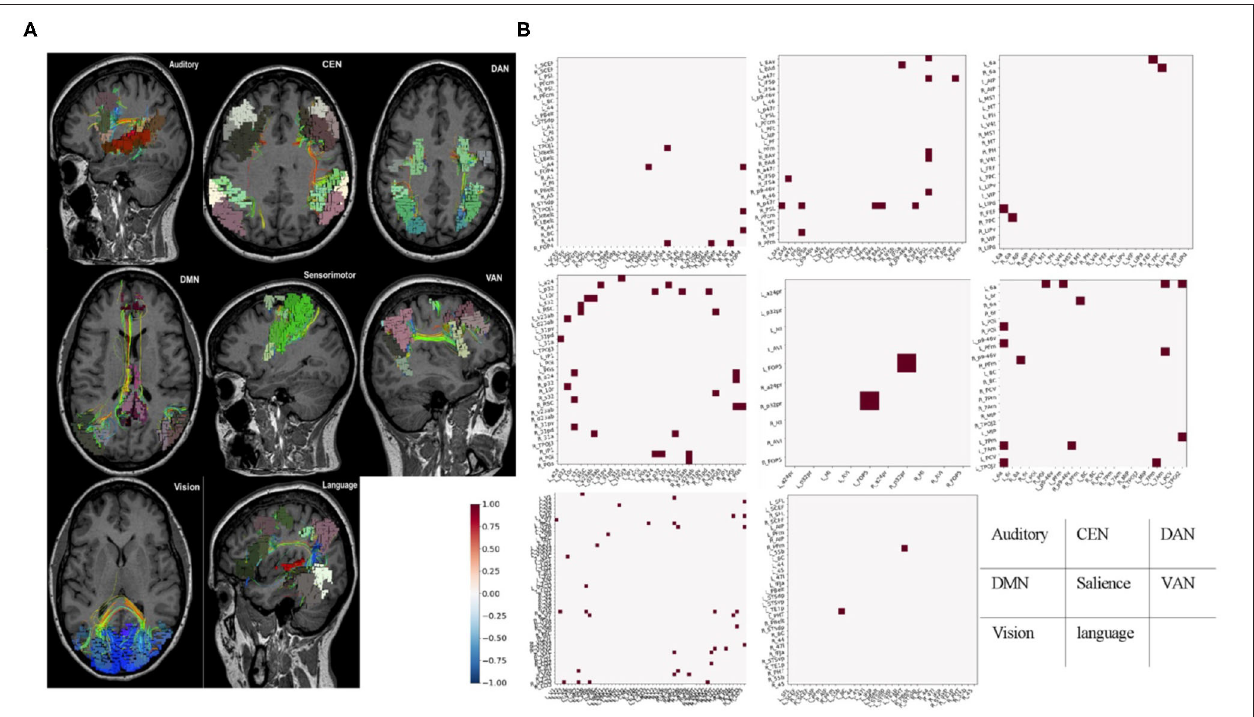
FIGURE 2 | Fiber tracts and fMRI-based brain network. (A) Parcellations and fiber tracts–based brain network pulled out from the machine learning algorithms. Three-dimensional rendering of parcellations and tractography-based MRI images for identified set of seven canonical brain connectivity networks that Only shows tracts within areas of the network. (B) Example submatrices of structural anomalies for the same patient based on affiliation in the same brain-network with (A) . Normal or high variances (excluded areas) were indicated in white. Dots represent areas with less diffusion tractography fibers traces between them and normal, age-similar subjects. These maps provided a network-by-network fingerprint. CEN, central executive network; DAN, dorsal attention network; DMN, default mode network; VAN, ventral attention